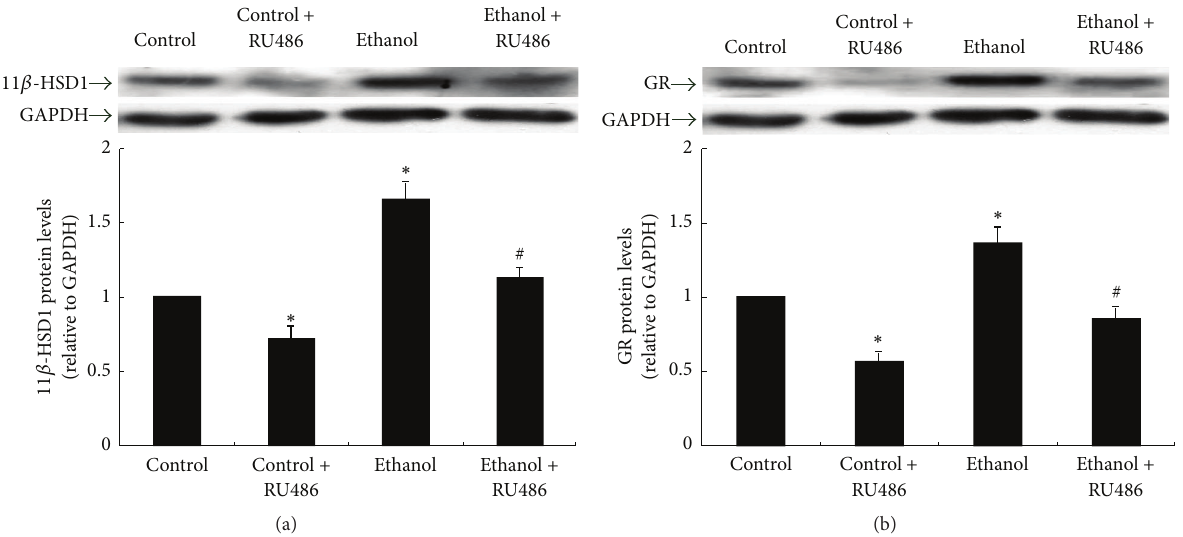
Figure 4: 11 𝛽 -HSD1 and GR proteins in Hepa 1–6 cells. Groups of cells were treated with 100mM ethanol and/or 10 𝜇 M RU486, as described in Section 2. Protein levels are expressed relative to control and shown as the mean ± SEM. ( 𝑛 = 6 ). ∗ 𝑃 < 0.05 versus control; # 𝑃 < 0.05 versus ethanol.